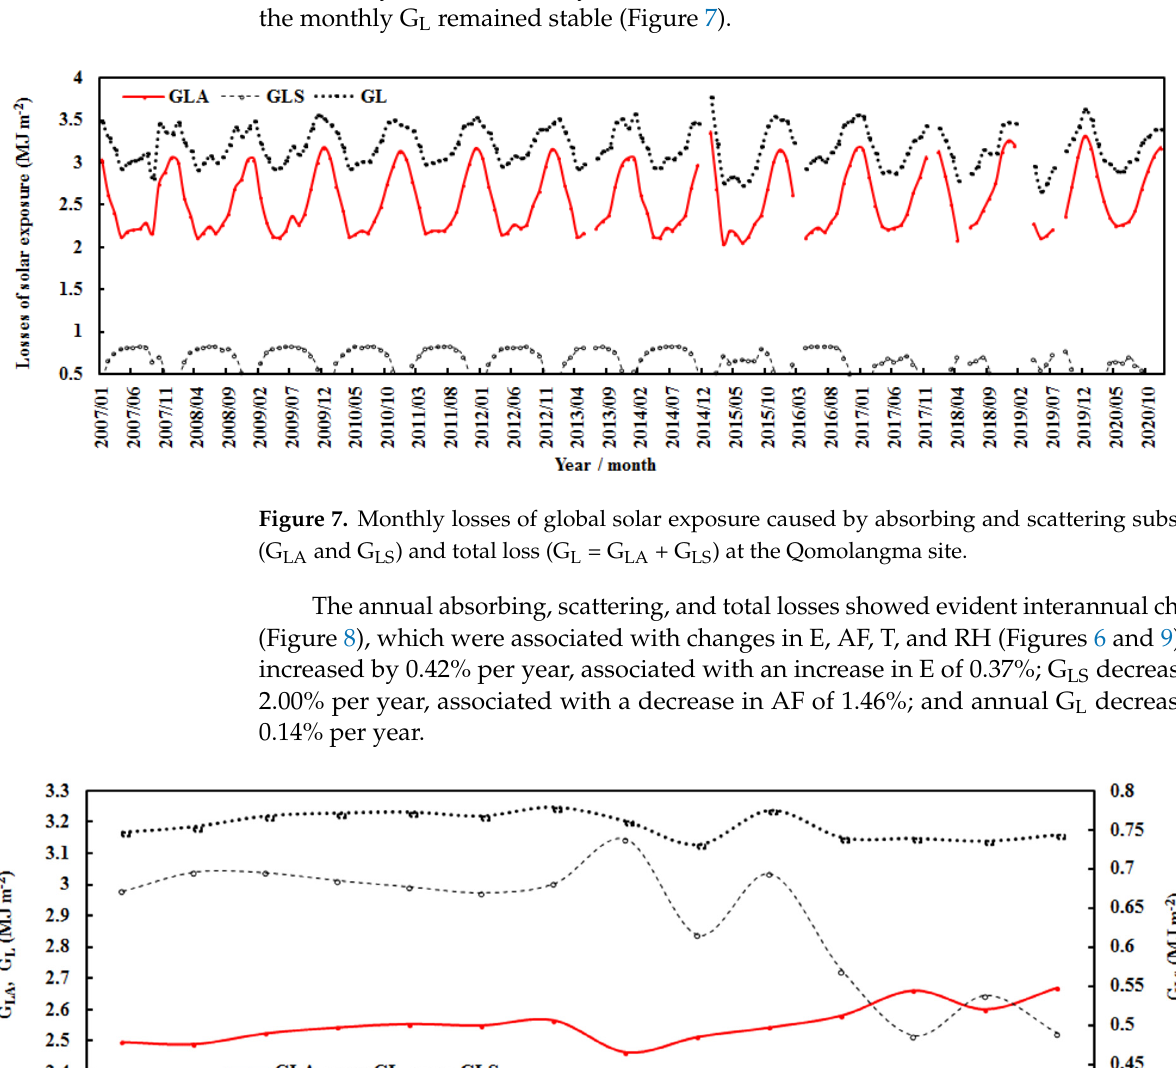
Figure 8. Annual losses of global solar exposure caused by absorbing and scattering substances (G LA and G LS ) and total loss (G L = G LA + G LS ) at the Qomolangma site.